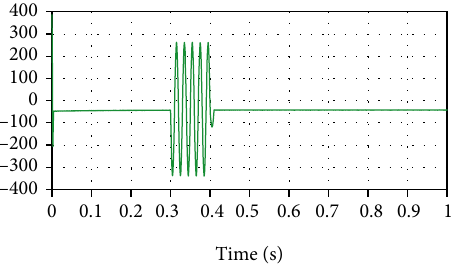
Figure 10: Compensation voltage v